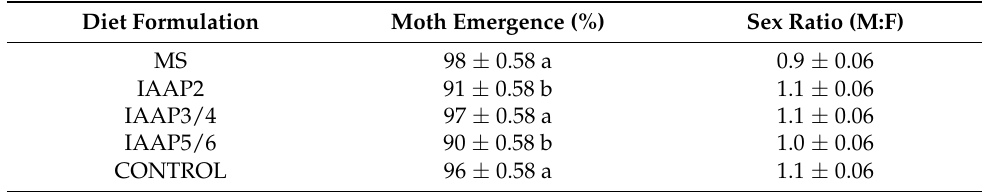
Table 6. Mean ( ± SE) emergence and sex ratio (male: female) of Eldana saccharina [ n = 130] from pupae harvested from the MS, IAAP2, IAAP3/4, IAAP5/6 and control diets. Means within columns with different lower-case letters indicate significant differences ( p <